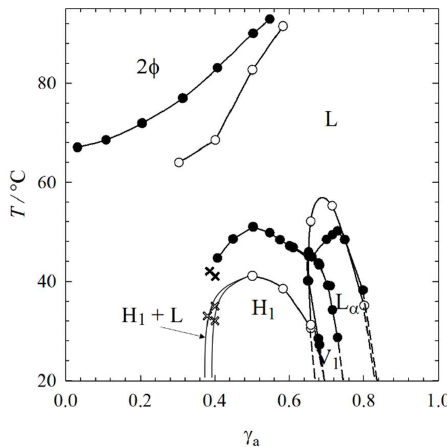
Figure 3. T– γ a phase diagram of the binary system H 2 O–C 12 E 7 (black symbols) and of the system H 2 O–C 12 E 7 –12-HOA (open symbols) at η = 0.015. The phase transition temperatures were determined by